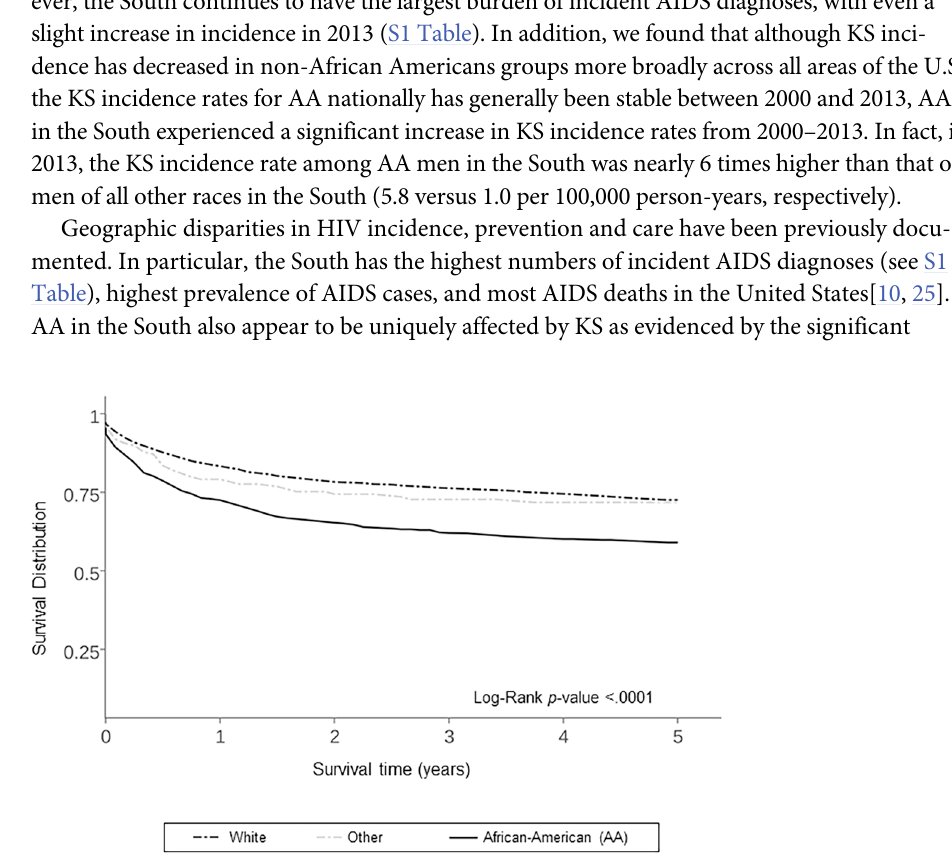
Fig 5. KS survival in the U.S. by Race, 2000–2013, N =